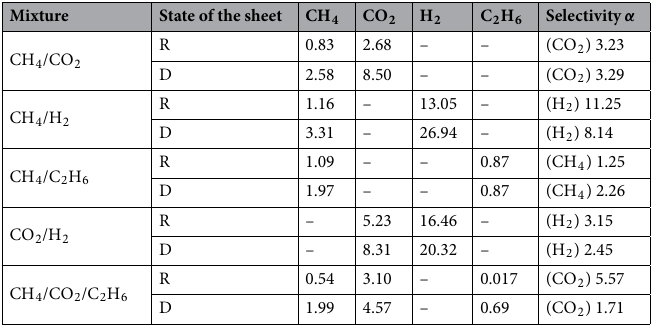
6 Table 2. Permeance (in 10 GPU) and selectivity of various gas molecules in the mixtures through the rigid (R) and deformable (D) graphyne-3